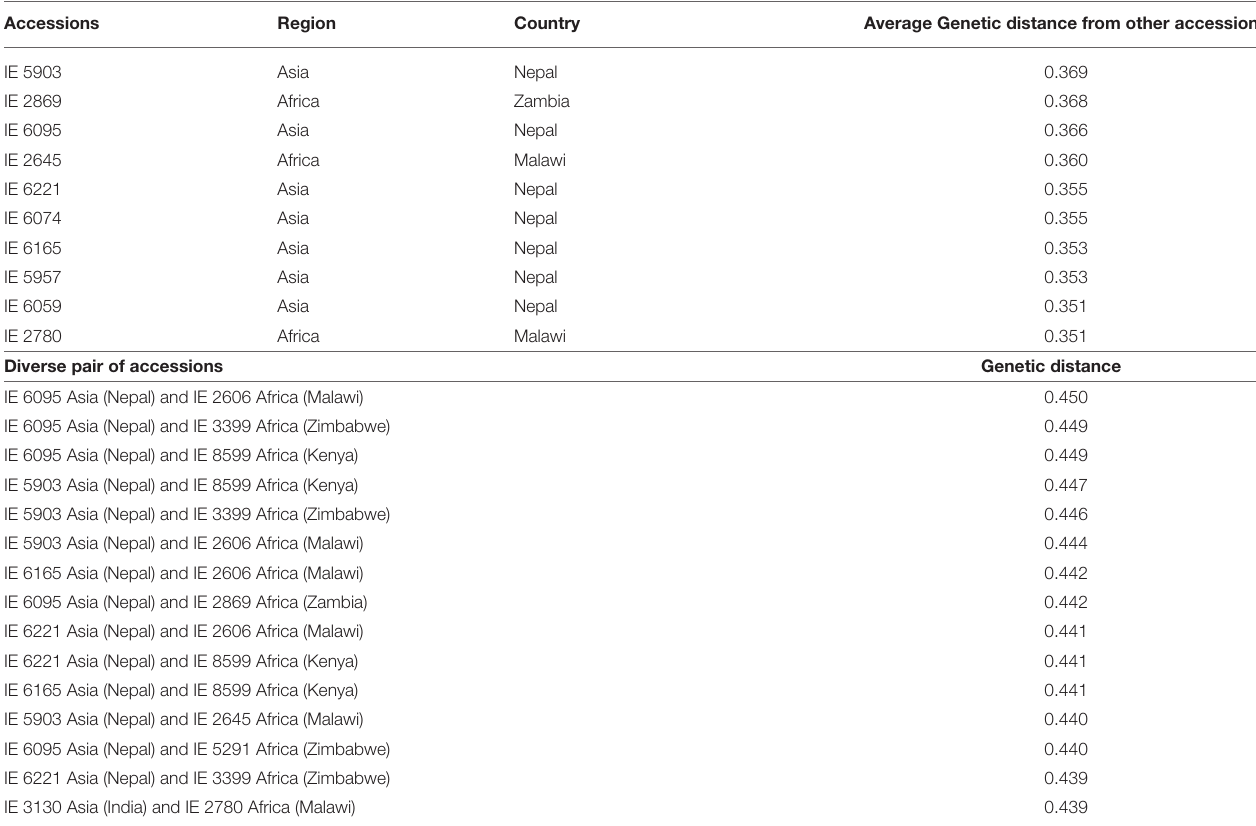
TABLE 3 | Genetically distant individuals and pairwise accessions identified using the modified Roger’s distance method.